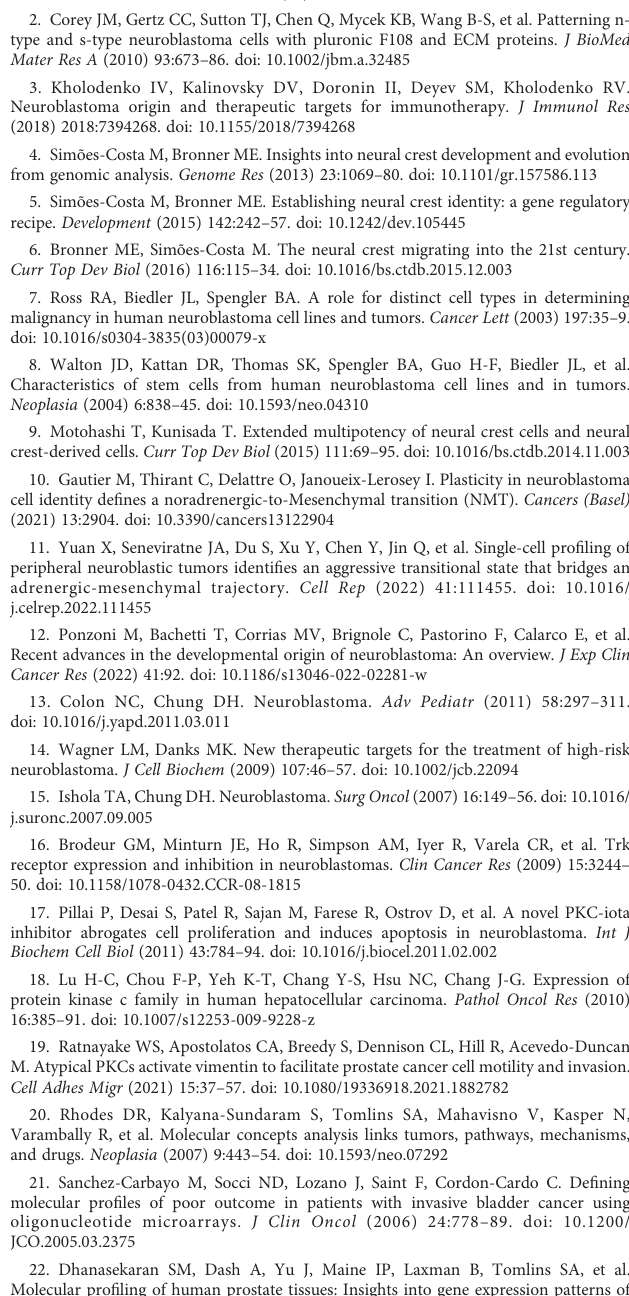
SUPPLEMENTARY FIGURE 1 Combinational treatments of ICA-1S and z -Stat demonstrate lack of synergistic effects on NB cell lines. Dose response curves showing (A) the effects of ICA-1S